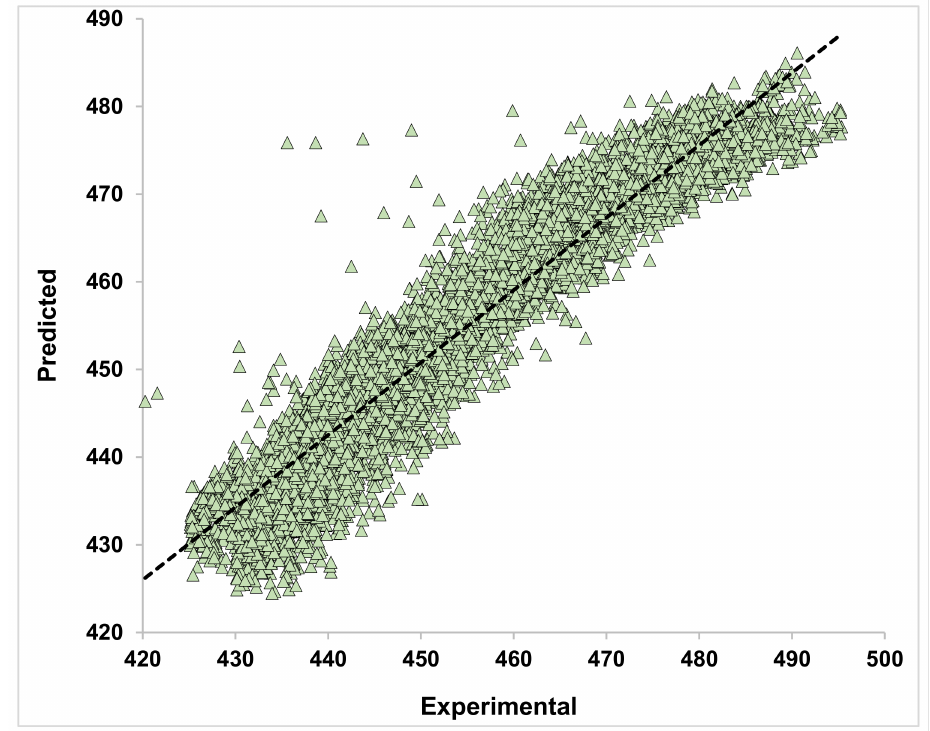
Figure 9. Training output from Linear regressor and experimental output compared along a line where the R 2 is 0.904 from the